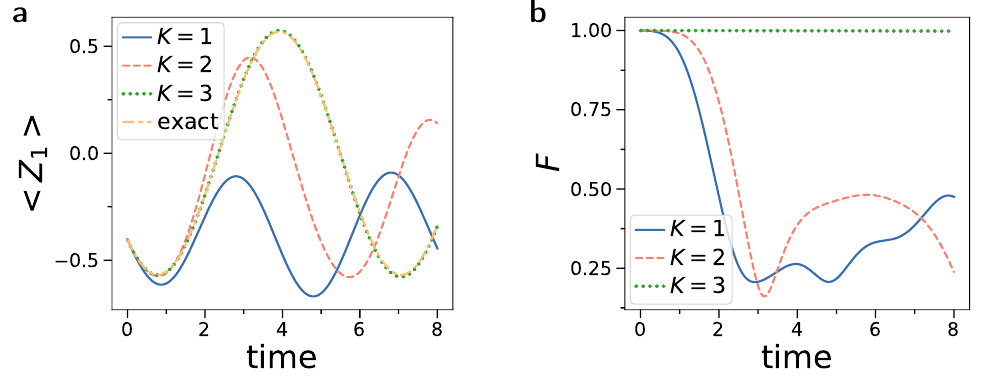
Figure 2: Time evolution of TQS on a 4 qubit state with Hamiltonian H on the IBM quantum processor ibmq_rome . a) Expectation value of 〈 Z with exact